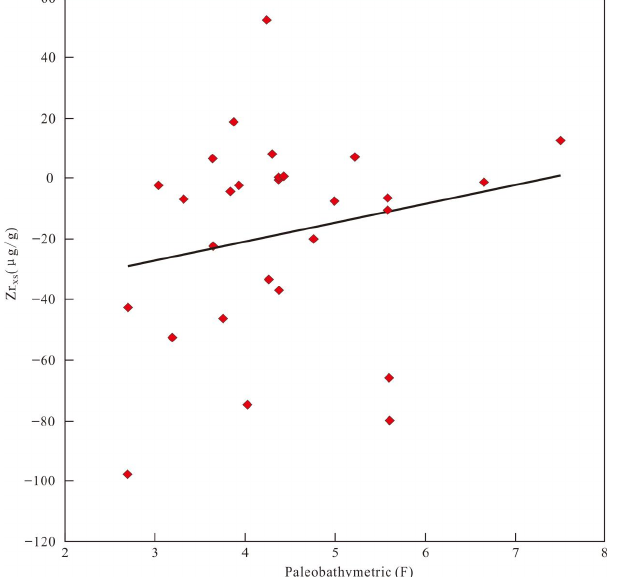
Figure 18. The relationship between paleoproductivity and paleobathymetry in the West Lishui Sag.